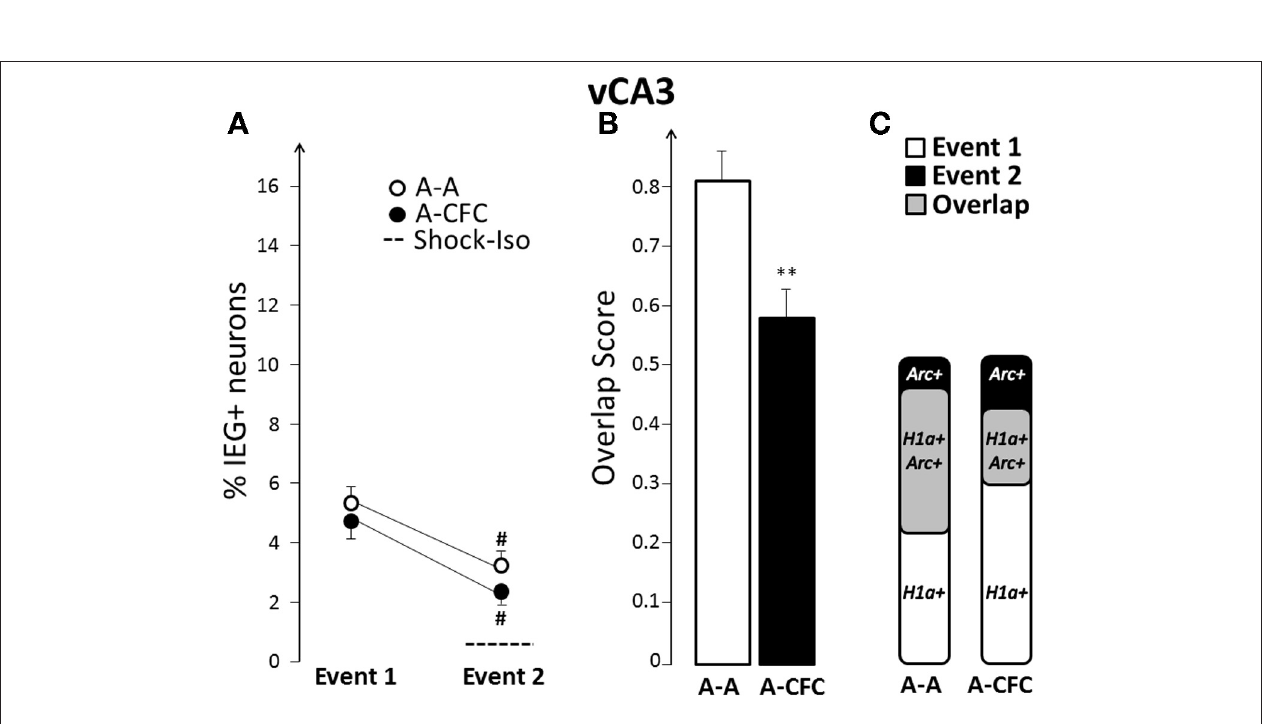
cells expressing Arc in response to foot shock alone. (B) Overlap scores; (C) Venn diagrams representing both size and overlap. ∗∗ p < 0 . 01 compared to the A-A group; # p < 0 . 05 compared to Event 1 of the same